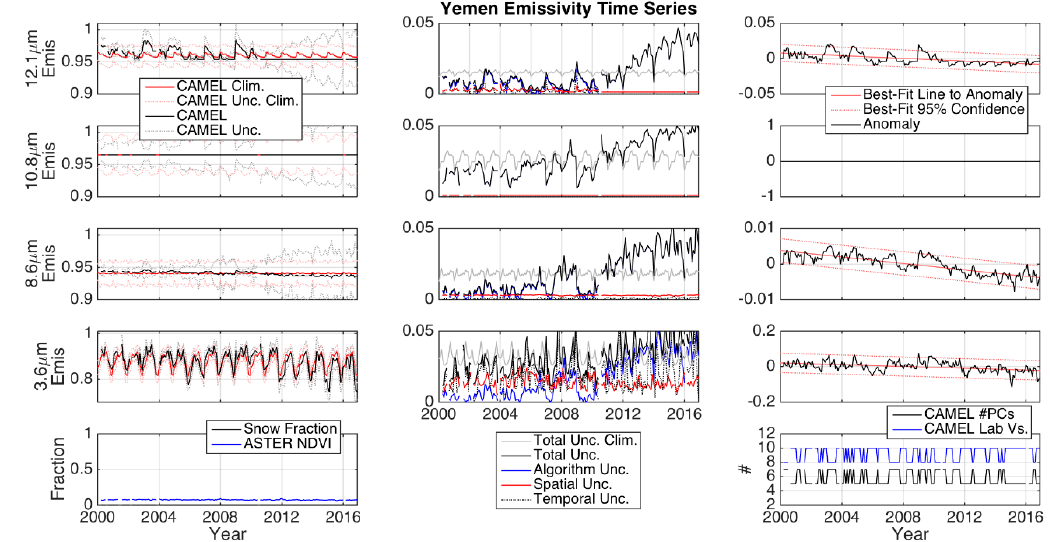
Figure 6. Same as Figure 4 except for the Yemen carbonate site.